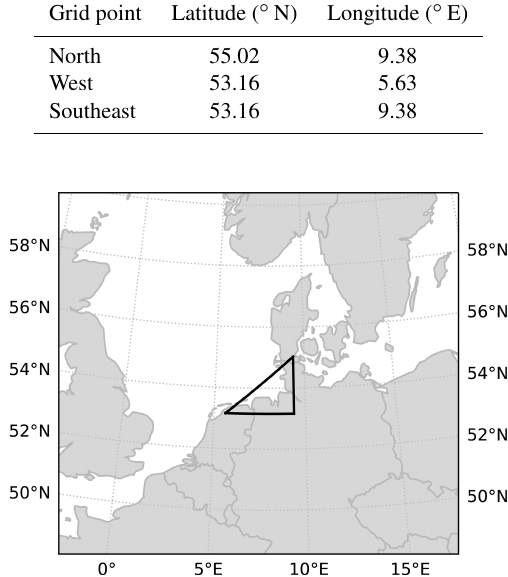
Figure 1. Map of northwestern Europe, showing the location of the German Bight